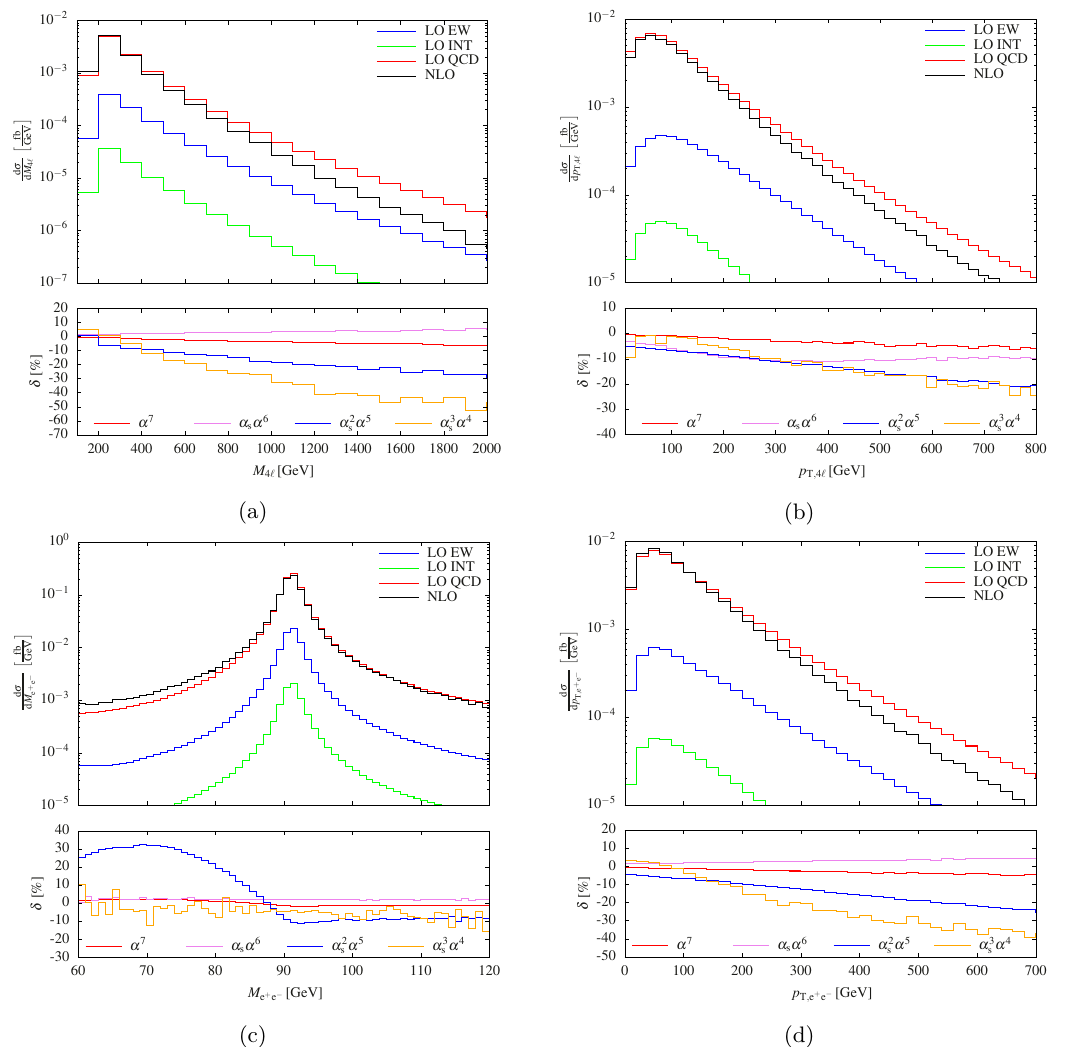
Figure 5 . Same as for figure 4 but for the observables: invariant mass of four-lepton system (top left), transverse momentum of the four leptons (top right), invariant mass of the electron-positron system (bottom left), and transverse momentum of the electron-positron system (bottom